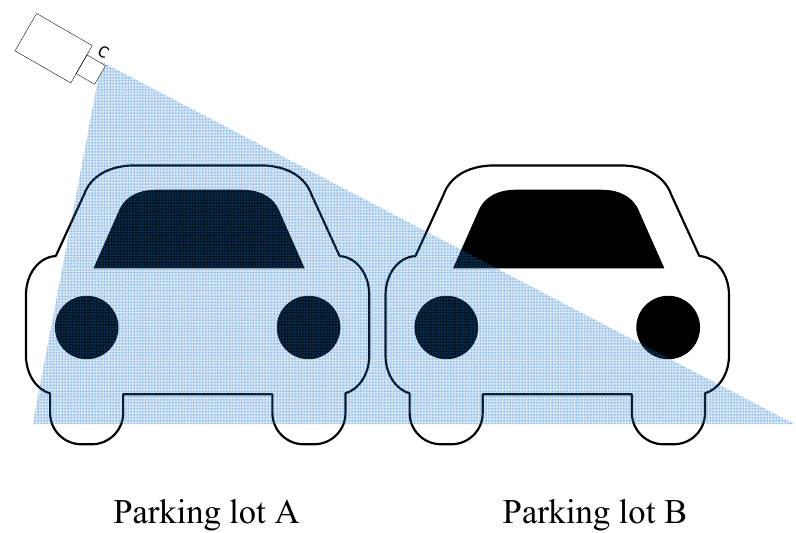
Figure 1. The potential privacy breach by an IoT based security camera installed for the parking lot “A” with an oversight on the parking lot “B”.